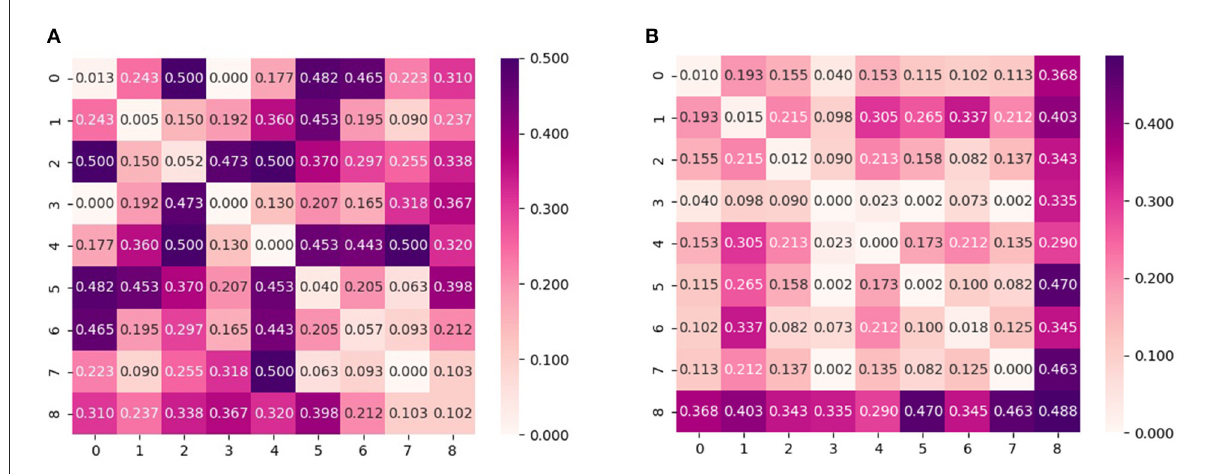
FIGURE3 Pair-wise cross-subject conditional shift with non-normalized and whitened features computed from subjects that performed physical activity on the treadmill . (A) No normalization. (B) Z-score normalization.